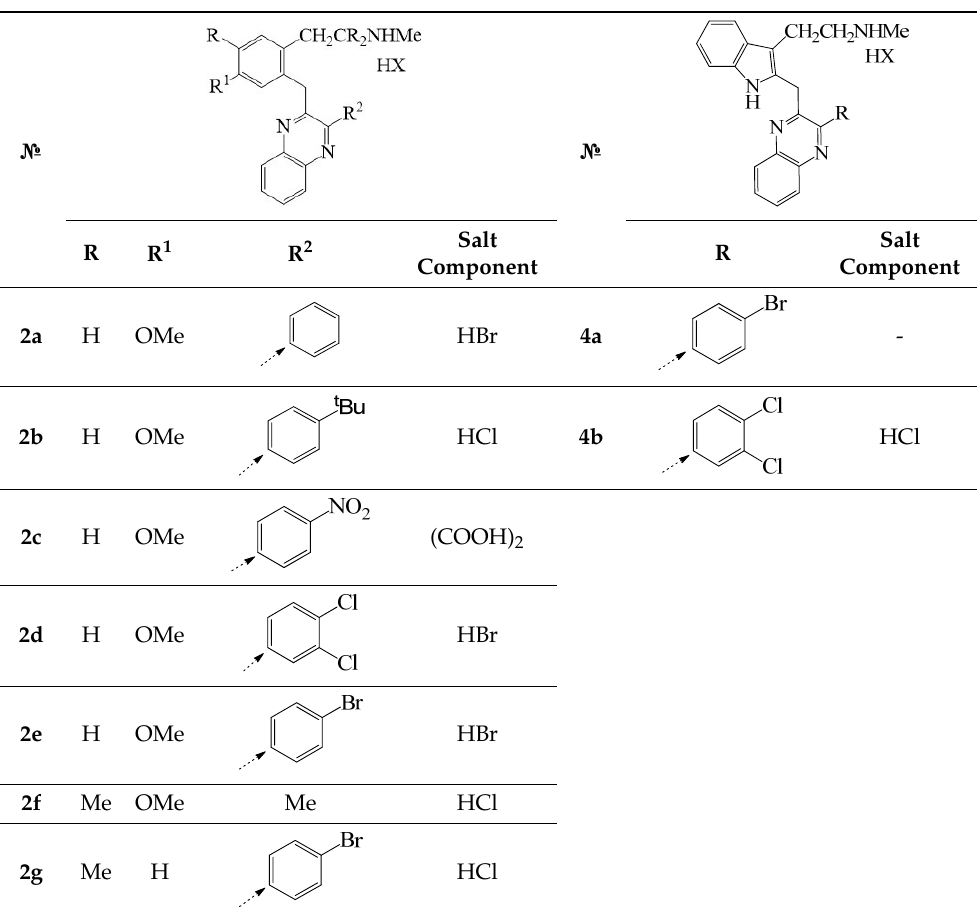
Table 1. Structure of studied compounds 2a–g, 4a–b .